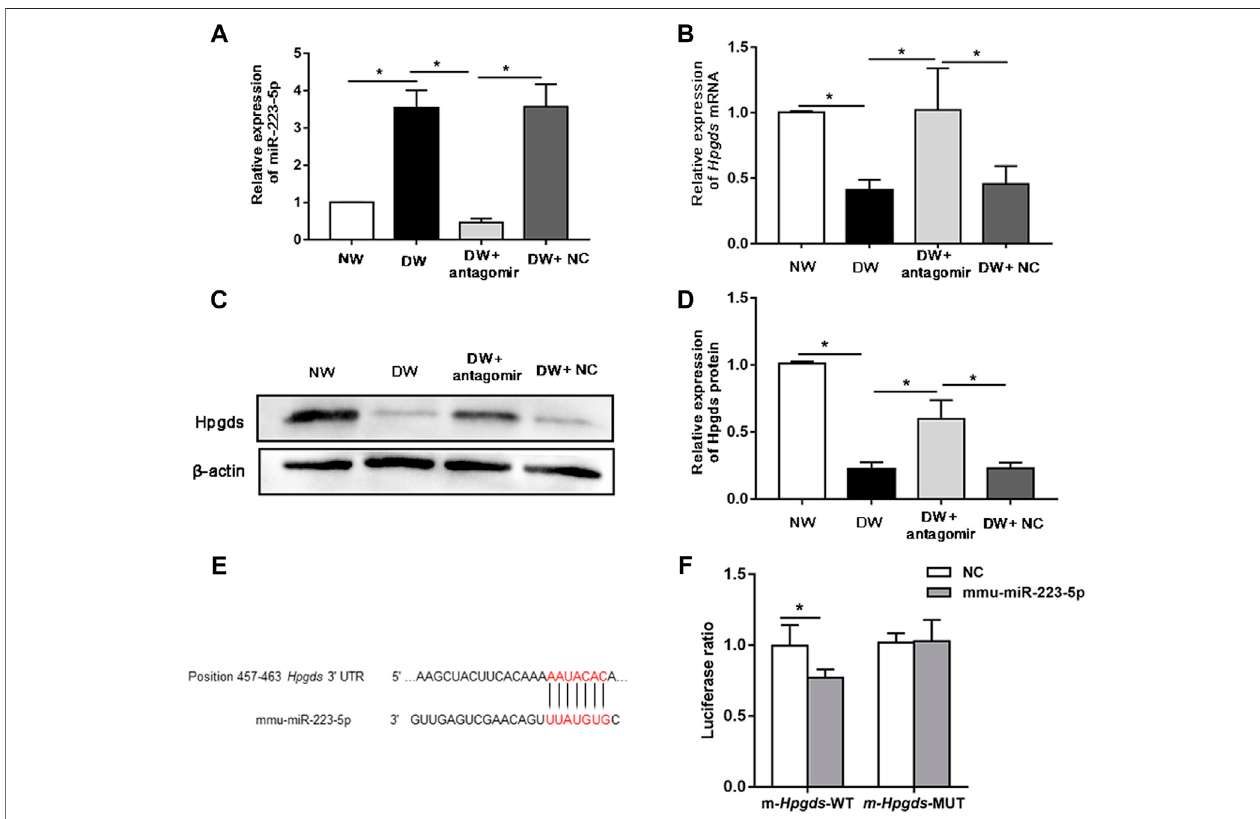
FIGURE4| Hpgds isthedirecttargetgeneofmiR-223-5p. (A) qRT-PCRresultsrevealingmiR-223-5pexpressionofinthecornealepitheliumharvested24 hpost- wounding of normal mice (NW group), diabetic mice (DW group), diabetic mice subconjunctivally injected with miR-223-5p antagomir (DW + antagomir group) or antagomirNC(DW+NCgroup). (B) qRT-PCRresultsrevealingmRNAexpressionof Hpgds inthecornealepithelium24 hpost-woundingofthesamefourgroups. (C,D) Western blotting showing the protein expression of Hpgds in the cornea 24 h post-injury of these four groups. (E) Schematic representation of the predicted interactingsite of mmu-miR-223-5p with Hpgds . (F) Luciferasereporter assayassessed the relative luciferase activity in HEK293T cells transfectedwith pMIR-REPORT Hpgds -WT-3 ′ -UTR or Hpgds -Mut-3 ′ -UTR upon transfection with miR-223-5p mimic or miRNA mimic NC. (A,B,D) Data were analyzed by one-way ANOVA. If signi fi cant, multiple comparations were then performed. (F) Data were analyzed by unpaired t-test. * p -value of <